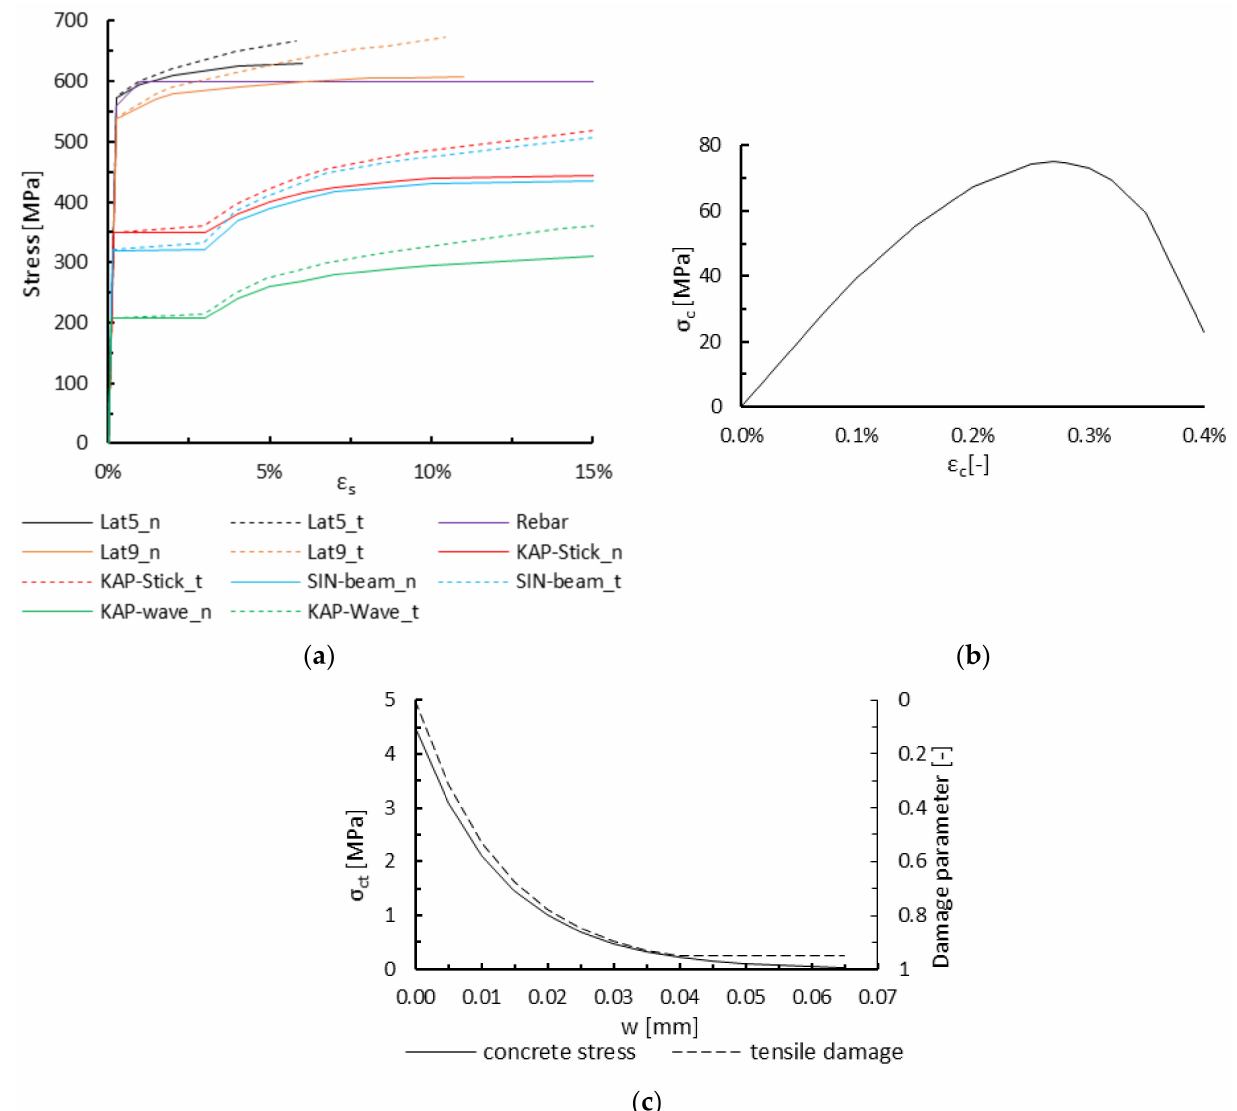
Figure 6. Material models used in the finite element software ( a ) steel materials with full lines for nominal stresses (n) and dashed lines for true stresses (t); ( b ) concrete compressive stress-strain relationship according to Sargin; ( c ) concrete tensile stress-crack opening relationship according to